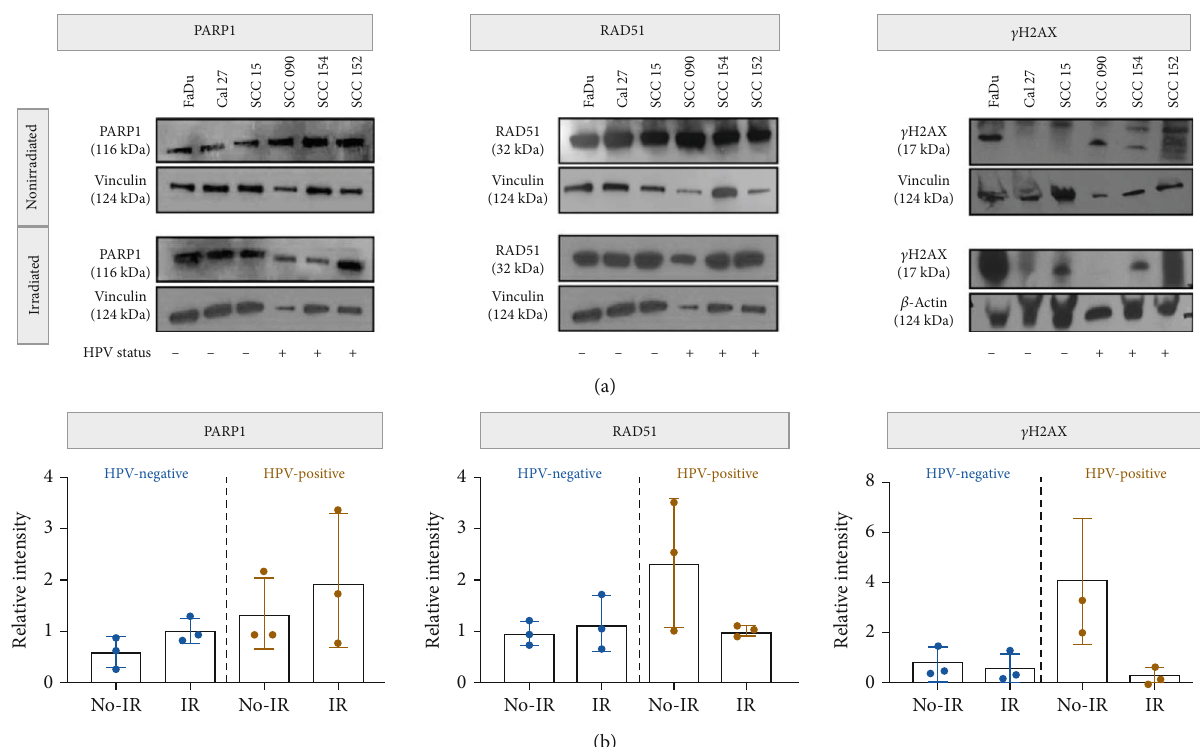
Figure 1: PARP1, RAD51, and ɣ H2AX expression in HPV-negative and HPV-positive cell lines. (a) Western blot analysis of three HPV- negative (FaDu, Cal 27, and SCC 15) and three HPV-positive (SCC 090, SCC 154, and SCC 152) cell lines, both with and without external beam irradiation (2 Gy). Vinculin and β -actin served as loading controls. For irradiated cell lines, protein extraction was performed 24 h postirradiation. For irradiated PARP1 and RAD51 detection, the same gel was used; therefore, the same loading control is considered. (b) Quanti fi cation of PARP1, RAD51, and ɣ H2AX from (a). Bars represent grouped mean ± SD of 3 HPV-/+ cell